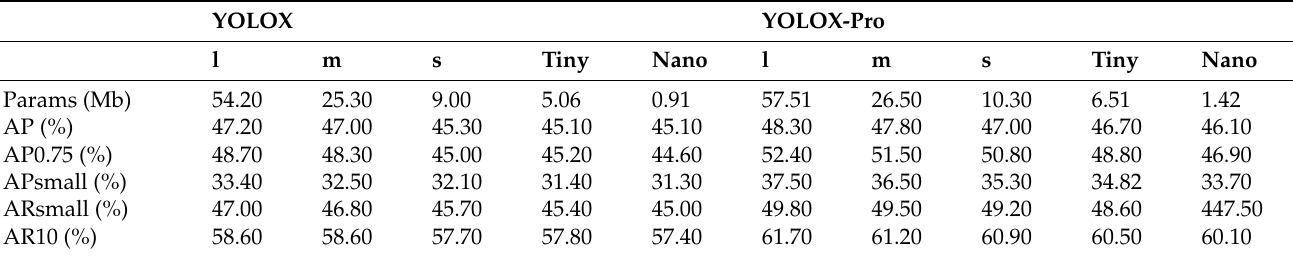
Table 6. Comparison of detection performance between YOLOX and YOLOX-Pro models. YOLOX